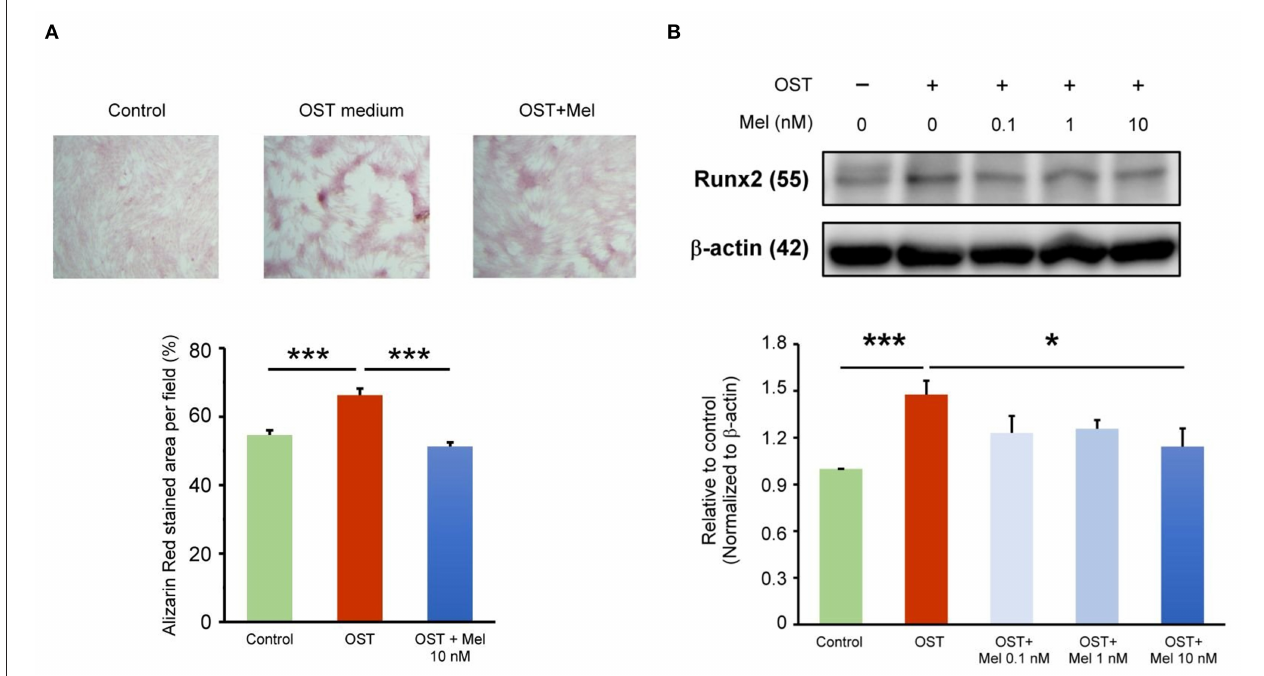
FIGURE 1 | Effect of melatonin on VIC calcification. (A) The representative Alizarin red S staining of VICs with or without melatonin (10 nmol/L). We quantified the positive stain area (red color) per field (three fields per treatment) in the VICs ( n = 5). The right panel presents the summary data of the percentage of calcification area ( n = 5). *** P < 0.005. (B) Western blotting for melatonin on Runx2 protein expression in OST medium treated VICs for five days ( n = 5). β -actin was used as an internal control. Data are presented as mean ± SEM. OST, osteogenic medium; Mel, melatonin. * P < 0.05, *** P <